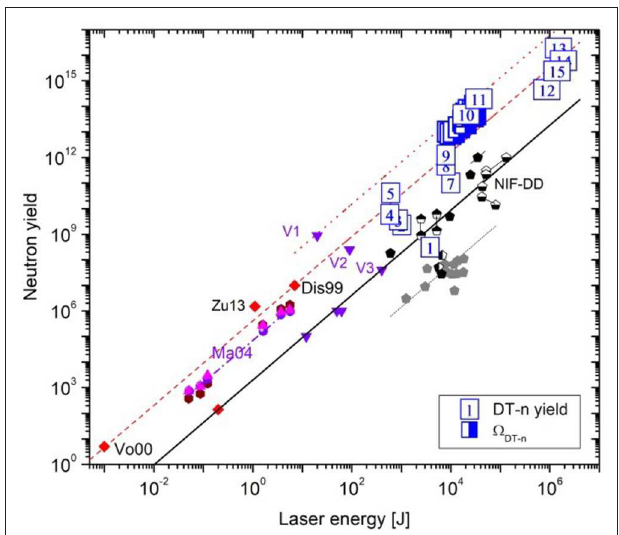
FIGURE 3 | Comparison of neutron yields from deuterium-tritium and deuterium-deuterium fusion reactions driven by different laser systems. Neutron yield from DT fusion: (cid:127) DT − n [ 9]; numbers with outline: 1 [39], 2 and 3 [40], 4 and 5 [41], 7 [42], 8 [43], 9 [44], 10 and 11 [14], 12 [45], 13 [38], 14 [46], 15